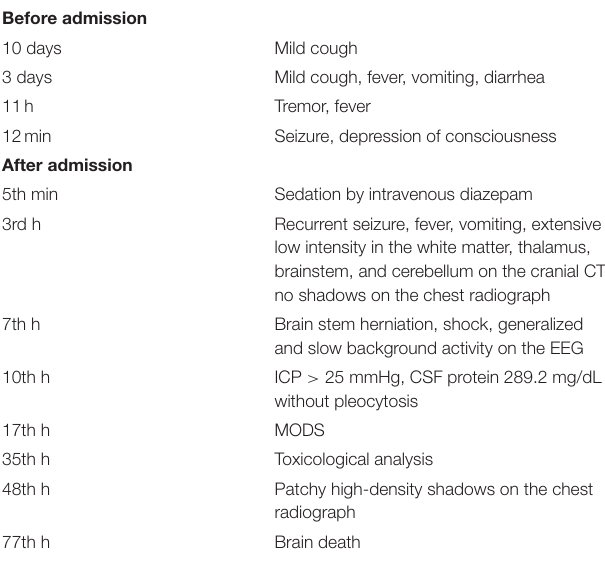
TABLE 1 | The timeline of